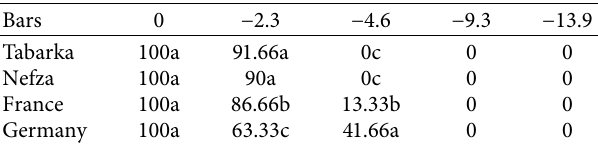
Means in each column followed by the same letters are not significantly different ( P > 0 .